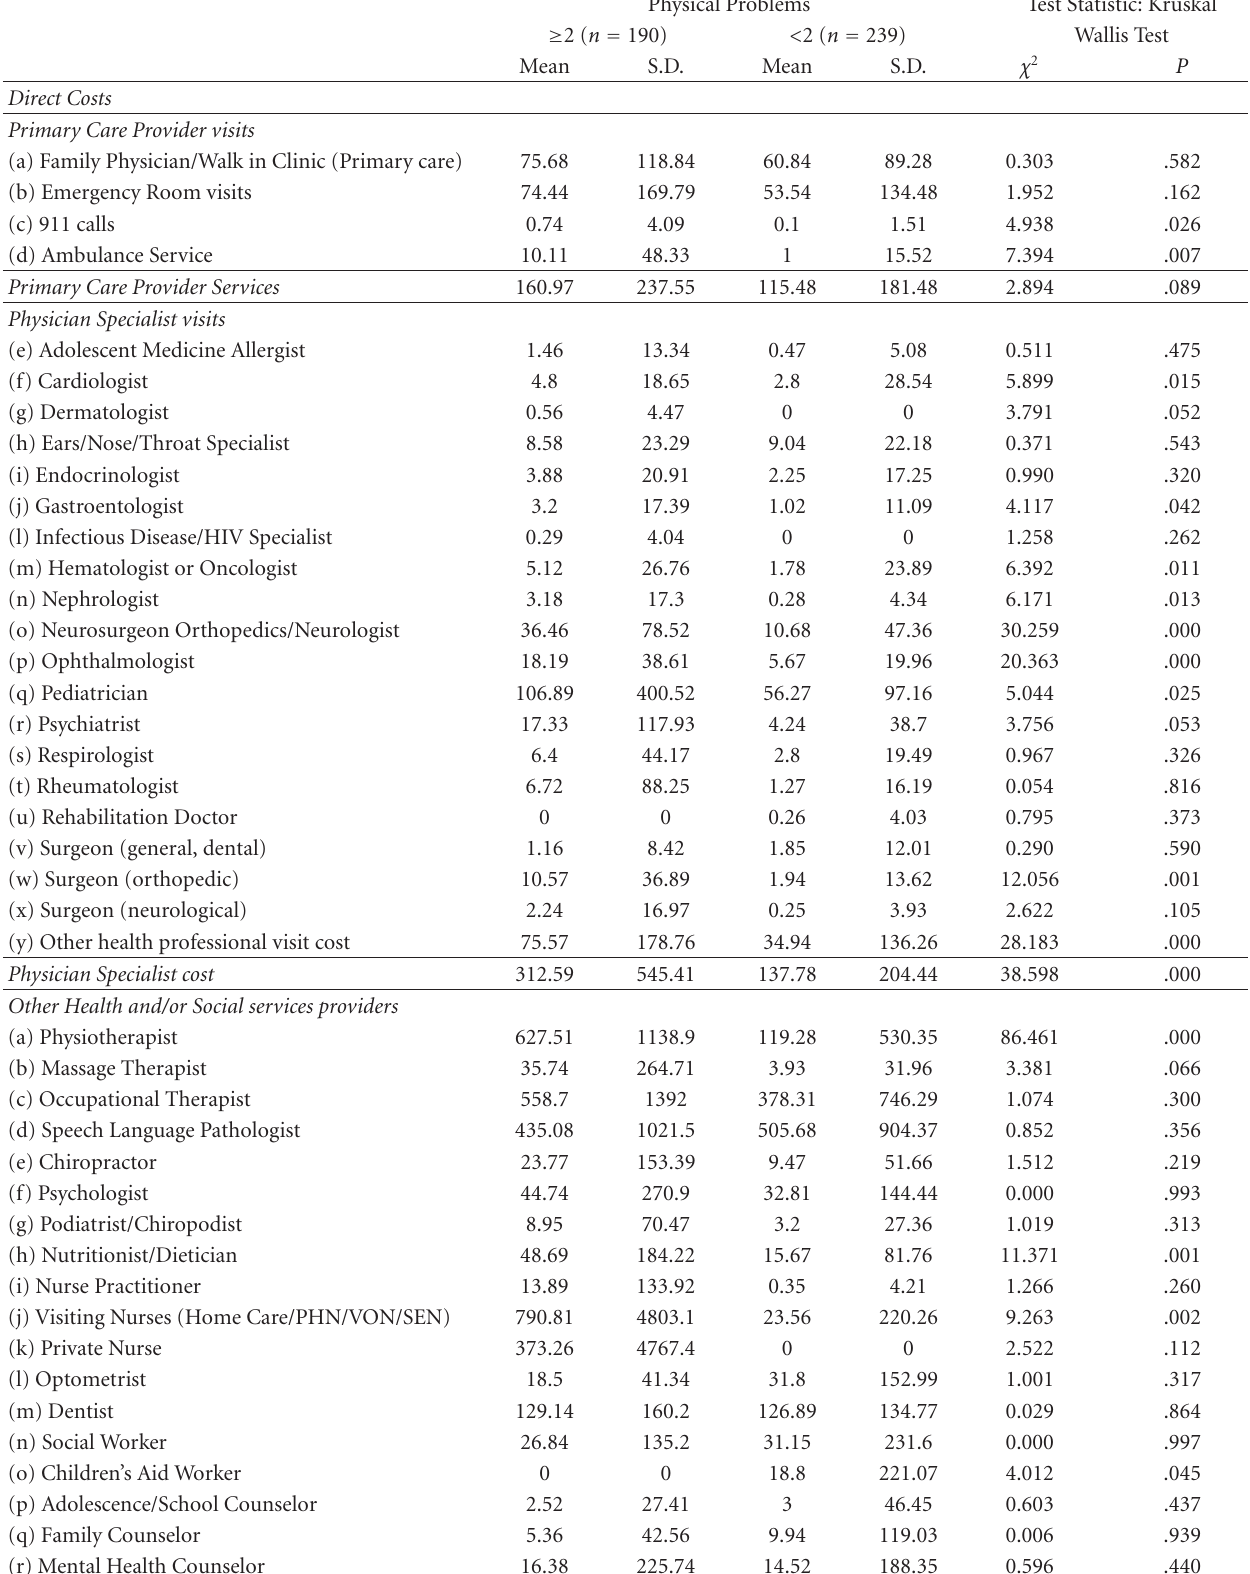
Table 7: Mean 6-month cost of child use of Health and Social Services Utilization by Physical Quality of